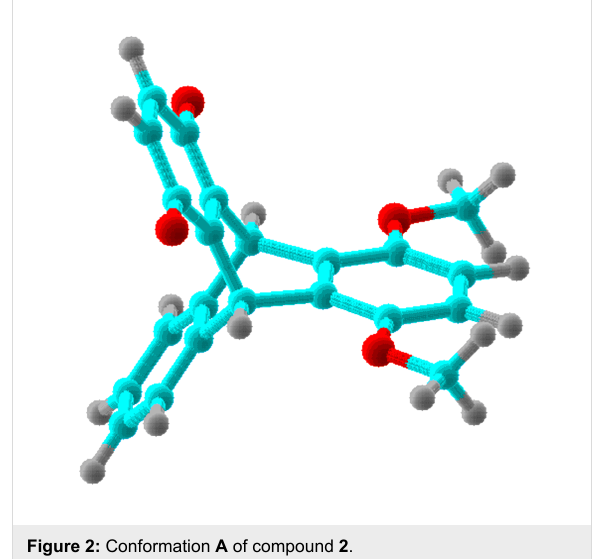
Figure 2: Conformation A of compound 2